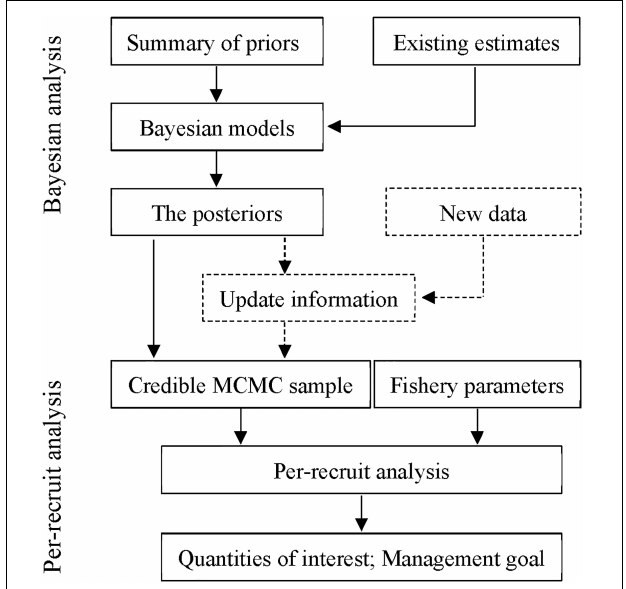
FIGURE 2 | Flowchart quantifying uncertainty for outputs of per-recruit analysis based on Bayesian